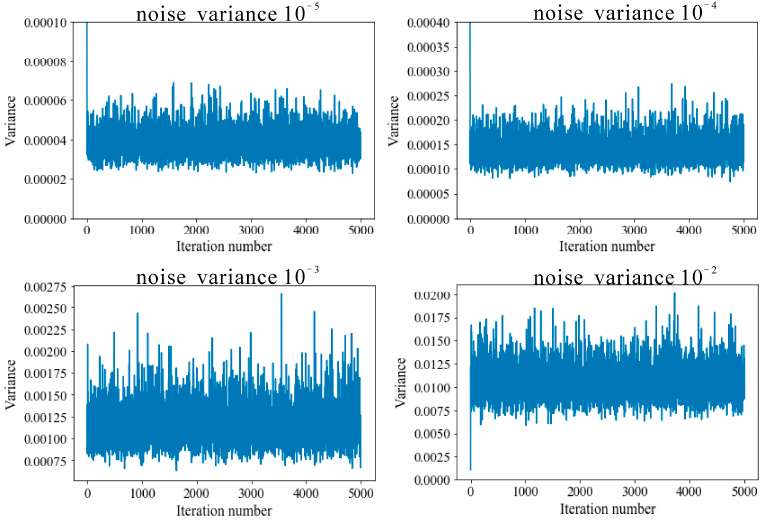
Figure 3. The noise variance sampling versus the number of iterations.